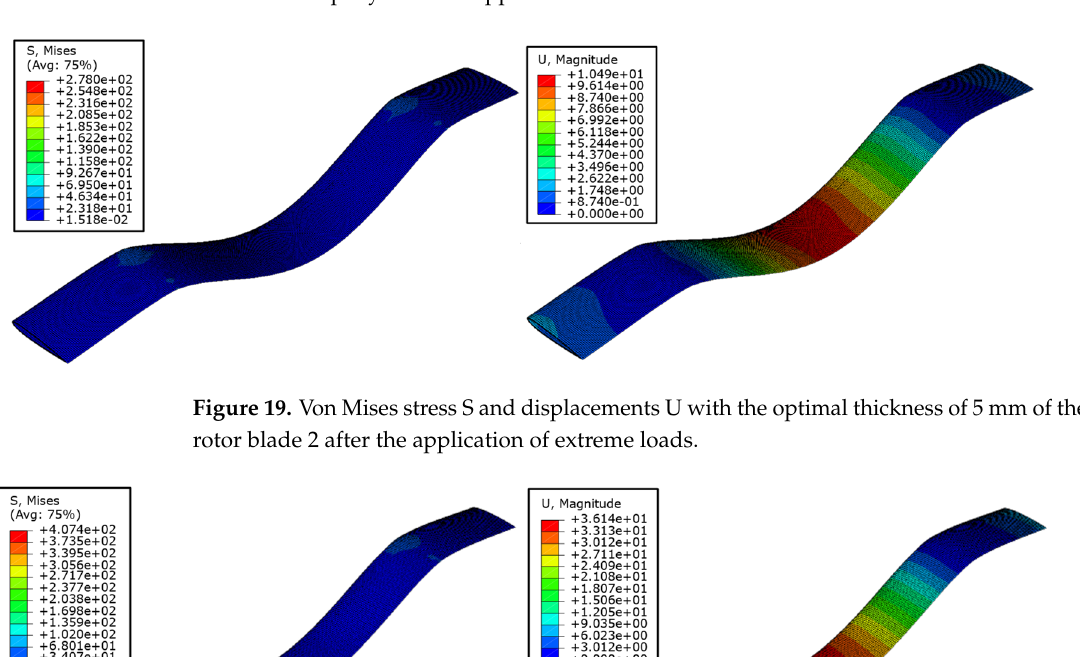
Figure 18. Von Mises stress S and displacements U with the optimal thickness of 5 mm of the rotor blade 1 in V-Epoxy after the application of extreme loads.